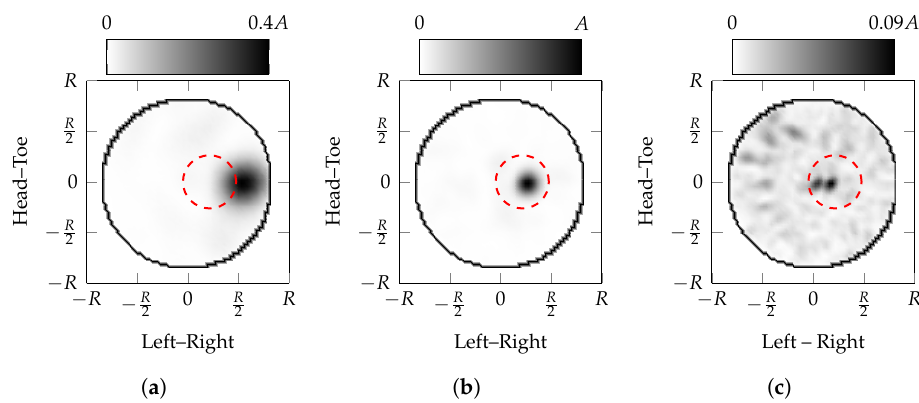
Figure 4. Coronal slices of the experimental PSF at the tumour location. The maximum intensity of images ( a , c ) are 40% and 9% of image ( b ). The normalised images with linear colour scales are displayed so that features can be more clearly identified. Images ( a–c ) are reconstructed with respectively. The location of the point scatterer is marked with the